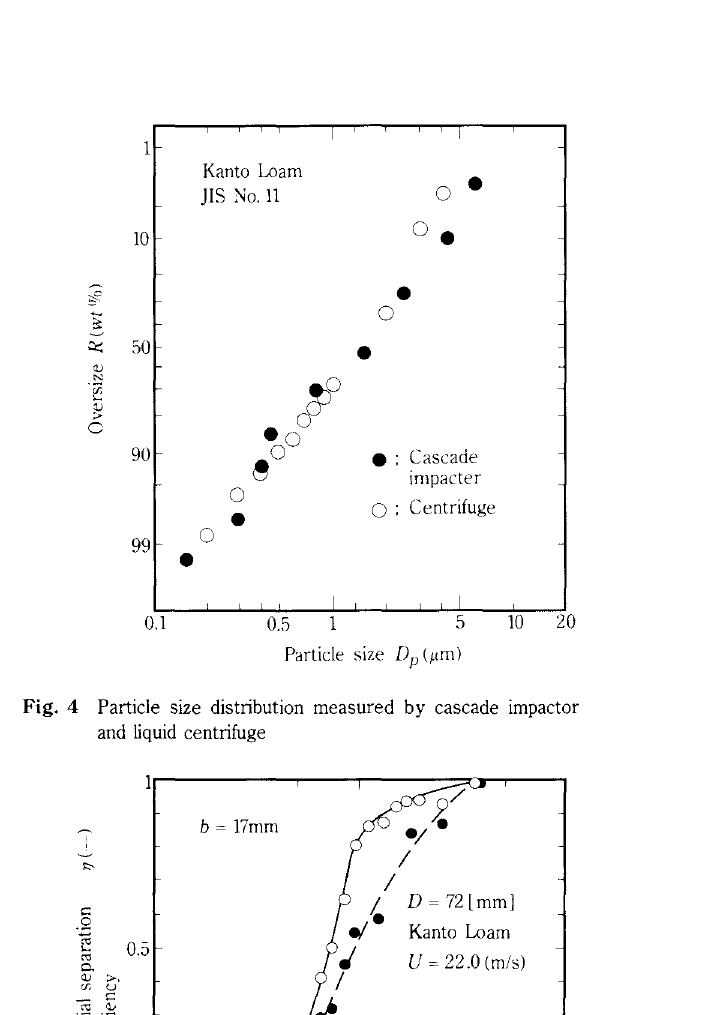
Fig. 5 Effect of cyclone wall with and without polishing on partial separation efficiency